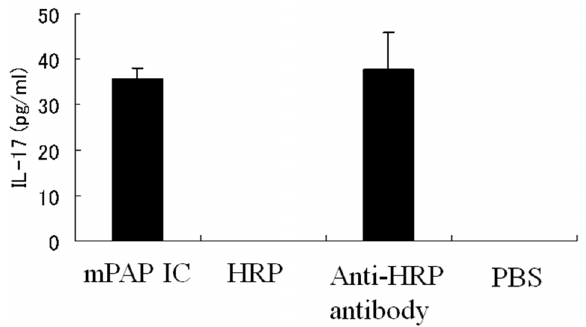
Figure 6. Neutrophils secrete IL-17 after stimulation in vitro. Neutrophils (8 6 10 6 cells/ml) collected from the bone marrow cells of B6 mice were cultured for three hours, followed by incubation with mPAP: murine peroxidase (HRP) -anti-peroxidase immune complex (IC), HRP only, anti-HRP antibody only or PBS for additional one hour. The supernatants were collected and the concentration of IL-17 was measured by ELISA. The results were reproducible in four independent experiments and the representative results are